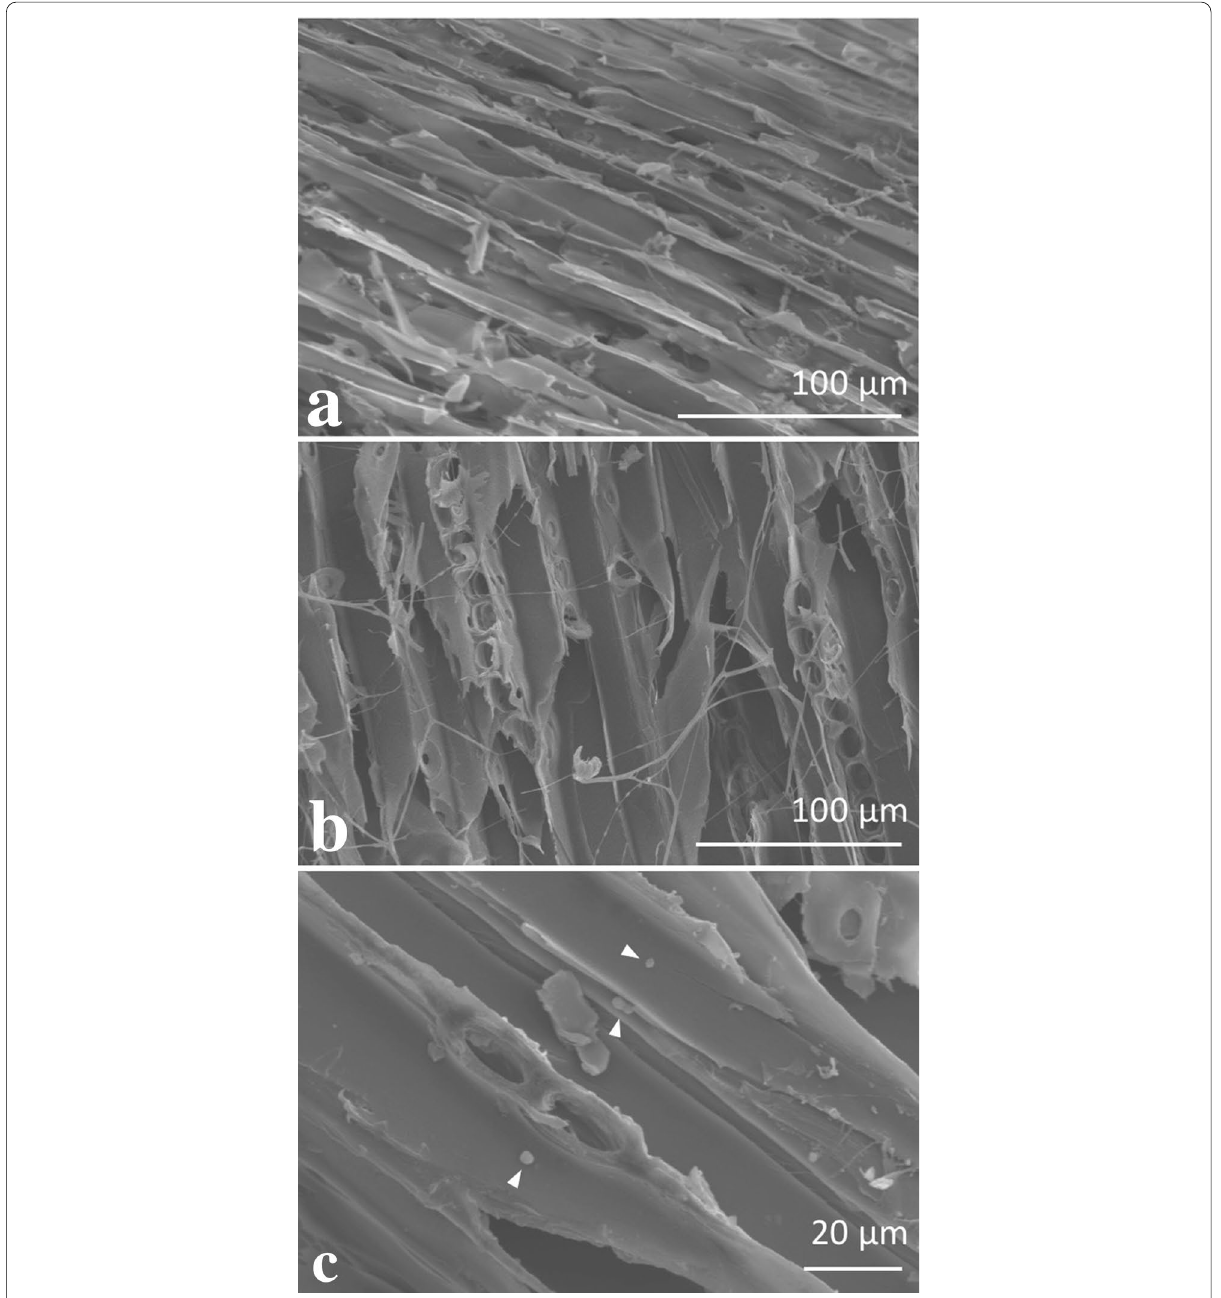
Fig. 4 Scanning electron microscopy observation of cell walls of wood. a Thinned cell walls in the aerial section; b spreading mycelia around wood tissue in a relatively shallow part of the aqueous section; c wood tissue in the aqueous section, where a few spherical cells were observed